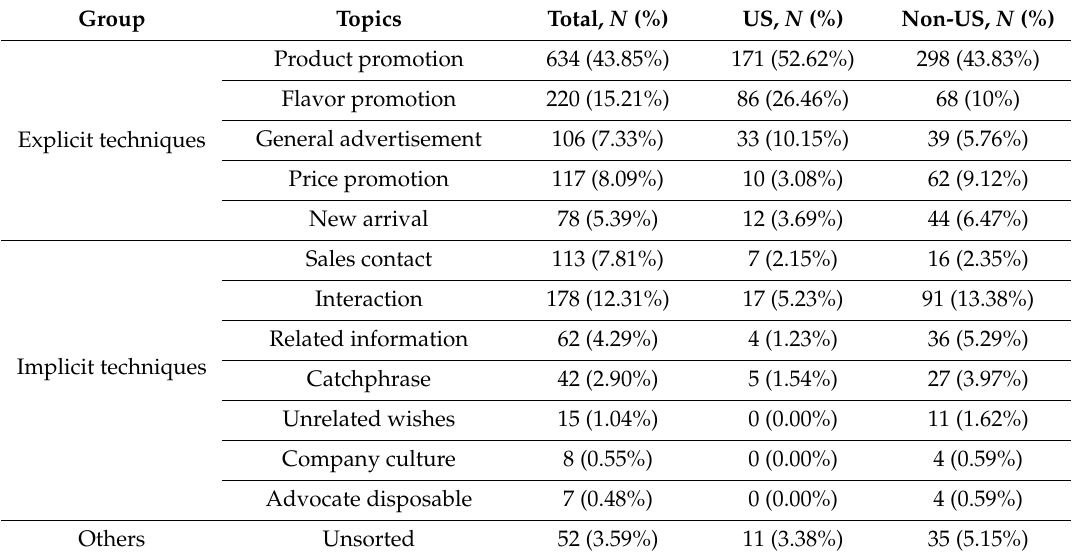
Table 2. Topics related to disposable e-cigarettes discussed on Twitter and comparison of topics between tweets from the United States (US) and non-US